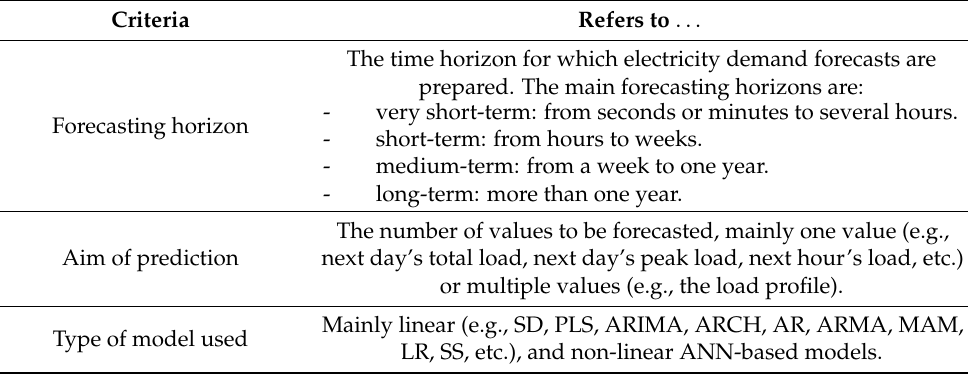
Table 3. Main criteria commonly used to classify demand forecasting models. Criteria Refers to . . .